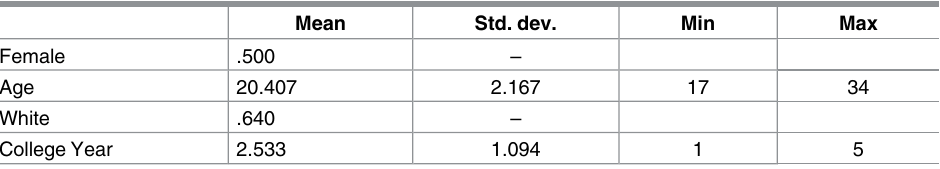
Table 1. Descriptive Statistics of the Participants’ Demographics. Mean Std.